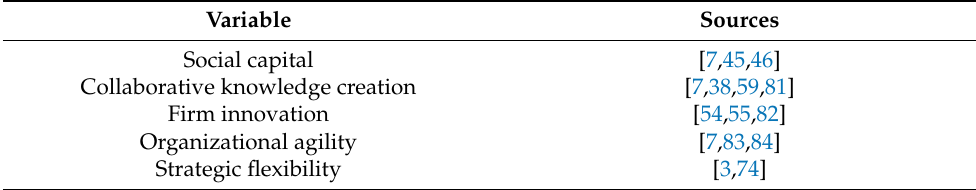
Table 1. Constructs